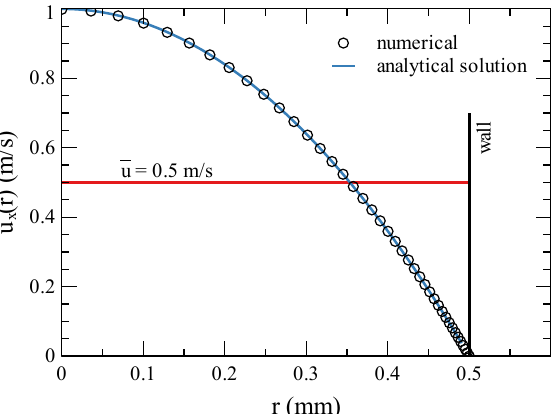
Figure 4. Comparison of the numerically calculated outlet velocity profile and the analytical solution. The study was carried out for water (Pr = 6.99), ω = 0.1047rad/s, Re = 497 ( ¯ u = 0.5 m/s) and for a hydrodynamically developed flow profile (setting the UDF function at the